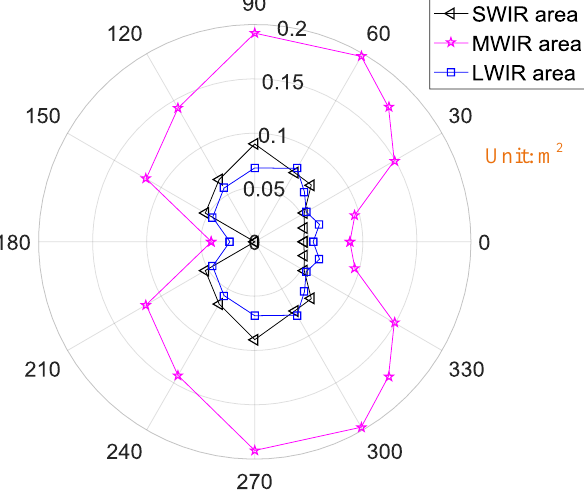
Figure 10. Orientation map of the engine’s radiation areas in different infrared (IR) bands.